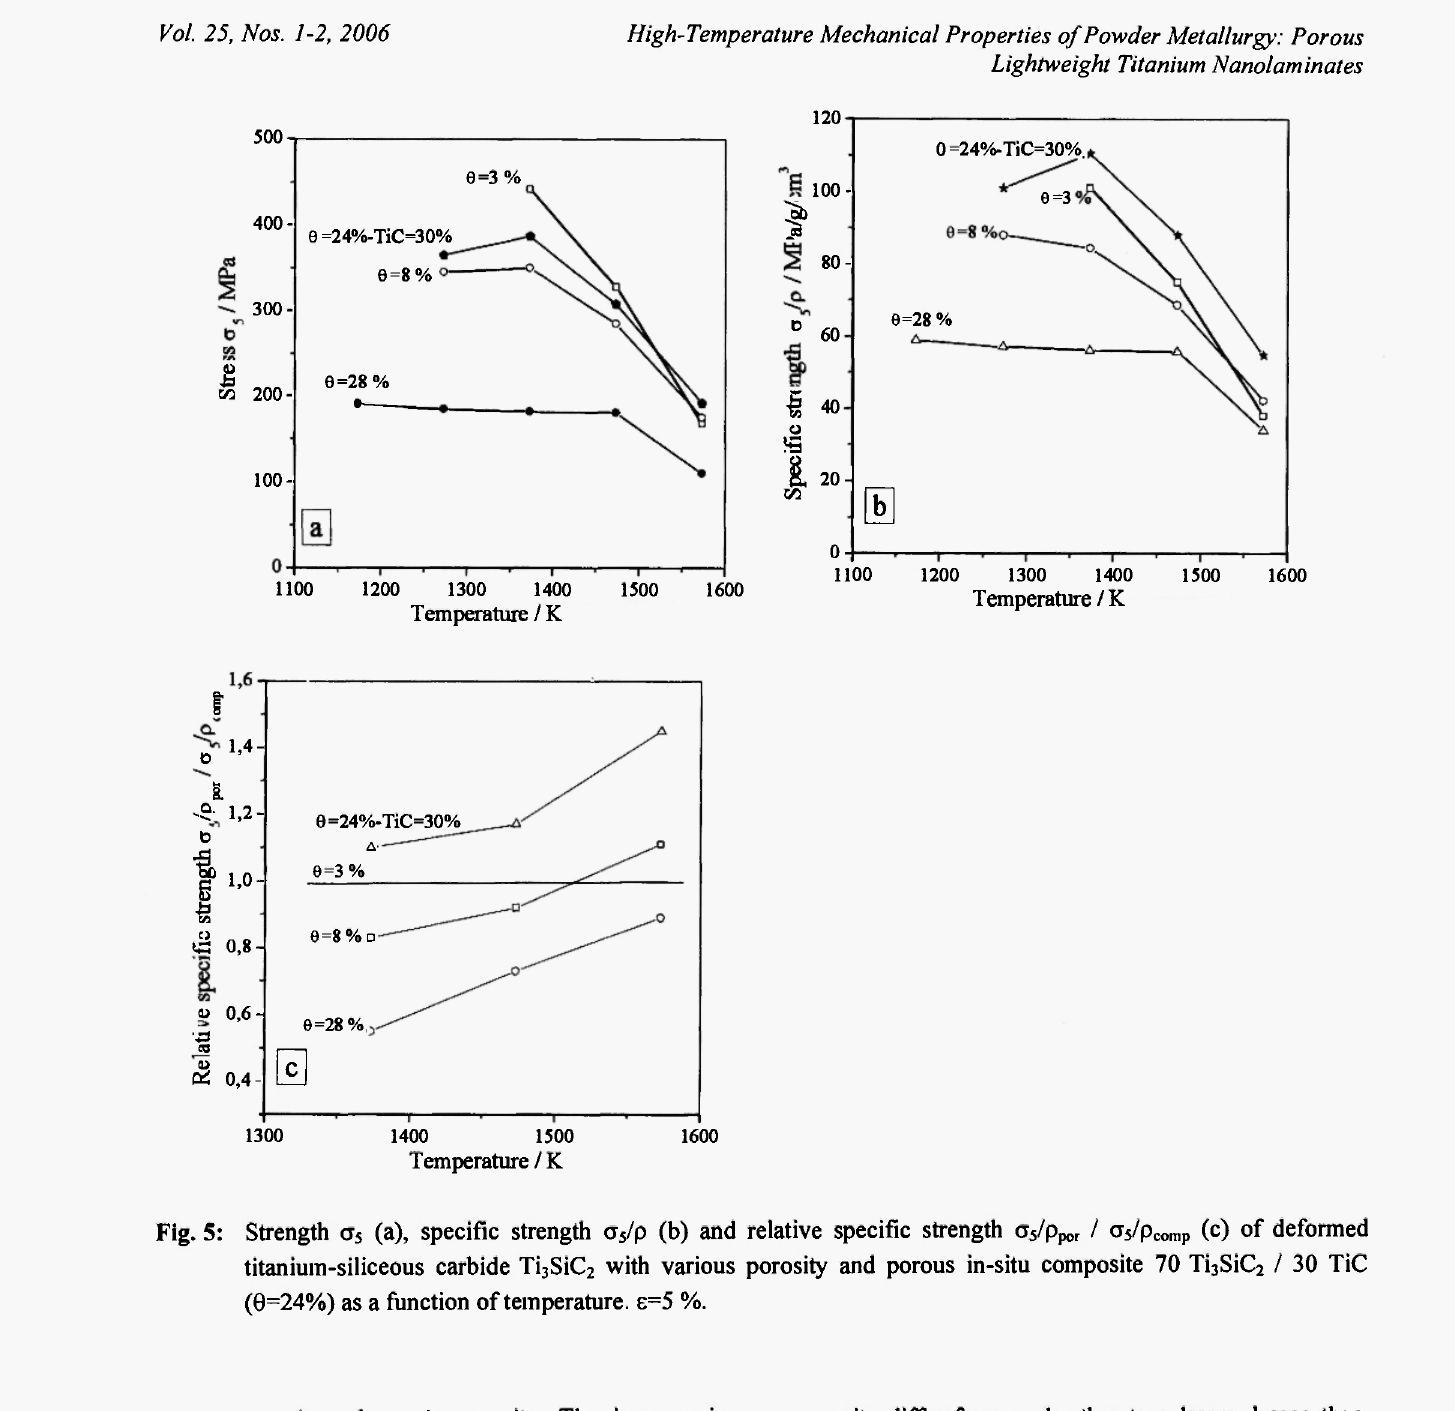
Fig. 5: Strength σ 5 (a), specific strength σ 5 /ρ (b) and relative specific strength σ 5 /ρρο Γ / σ 5 /ρ ςοη , ρ (c) of deformed titanium-siliceous carbide Ti 3 SiC 2 with various porosity and porous in-situ composite 70 Ti 3 SiC 2 / 30 TiC (9=24%) as a function of temperature. ε=5